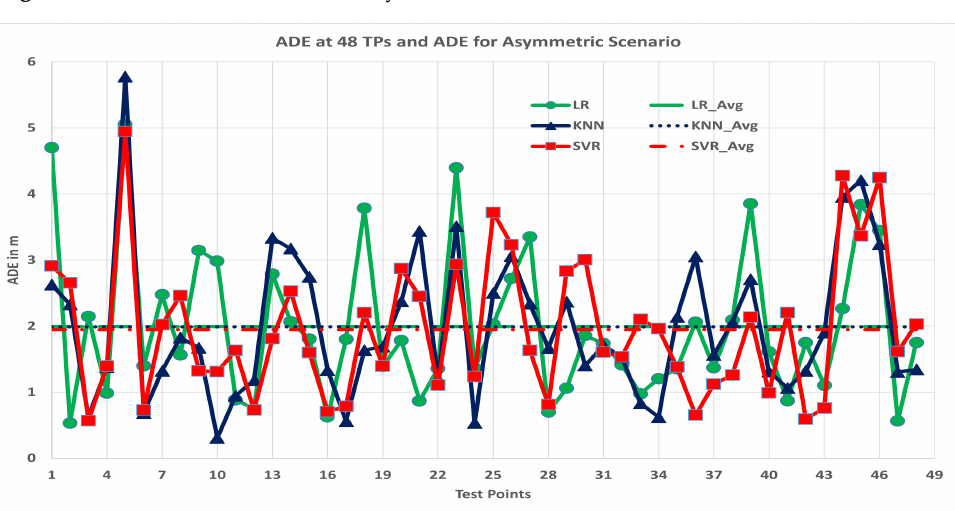
Figure 7. ADE at 20 TPs and ADE for symmetric scenario.